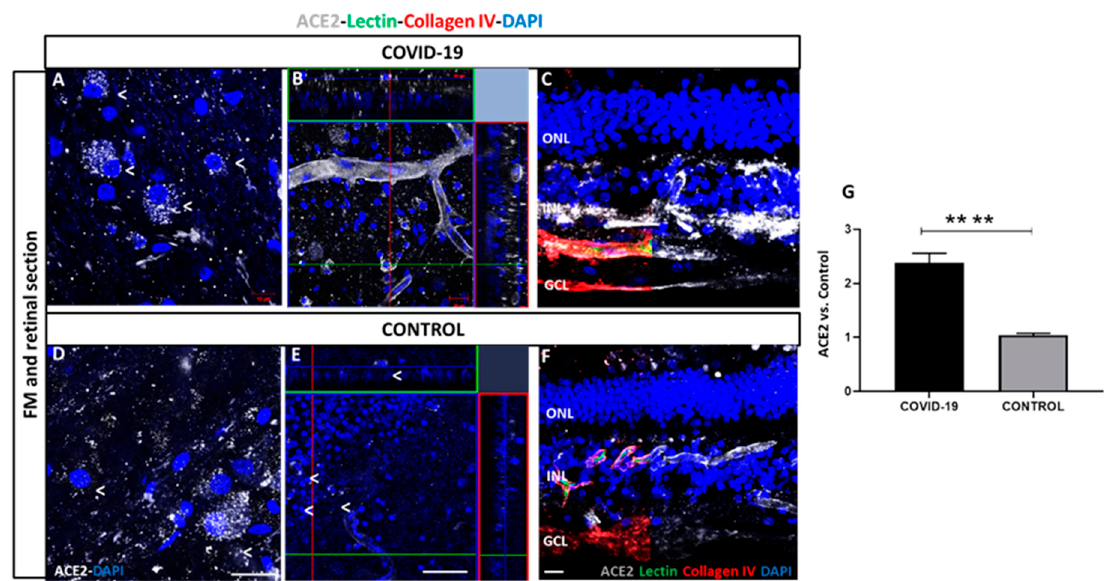
Figure 3. Angiotensin-converting enzyme 2 (ACE2) expression in COVID-19 ( A – C ) and control retinal vessels ( D – F ). ACE2 expression (white) observed in retinal ganglion cells (RGCs) in superficial vasculature in COVID-19 ( A ) and control ( D ) retinas. ACE2 is observed in cells in inner nuclear layer (INL) and ganglion cell layer (GCL) and endothelial cells in vessels of COVID-19 ( B ) and controls ( E ). ACE2 localization in Optimal compound tissue (OCT)-embedded retinas cross-sections previously labelled with lectin (green) and collagen IV (red) in COVID-19 ( C ) and controls ( F ). B and E represent an orthogonal projection of retinal vessels. 4 ′ ,6-diamidino-2-phenylindole (DAPI) (blue) label nuclei. ( G ) Quantification of immunofluorescence intensity in percentage of COVID-19 retinas vs. controls. **** p < 0.0001. Scale bar: 100 µm. Abbreviations: GCL (ganglion cell layer), INL (inner nuclear layer), ONL (outer nuclear layer).